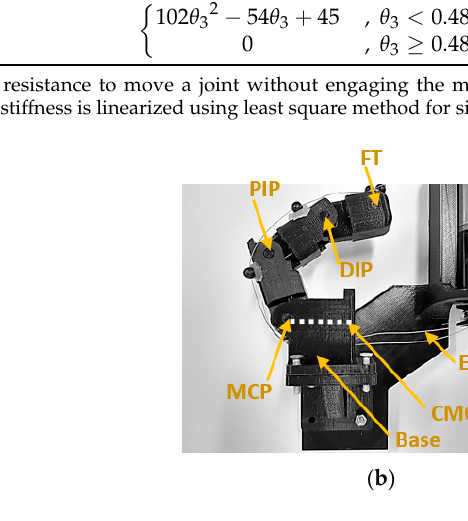
Figure 5. Artificial finger in its initial position for assessing ( a ) flexion and ( b ) extension. Note: the exotendons are not under tension since the artificial finger is in a relaxed state.